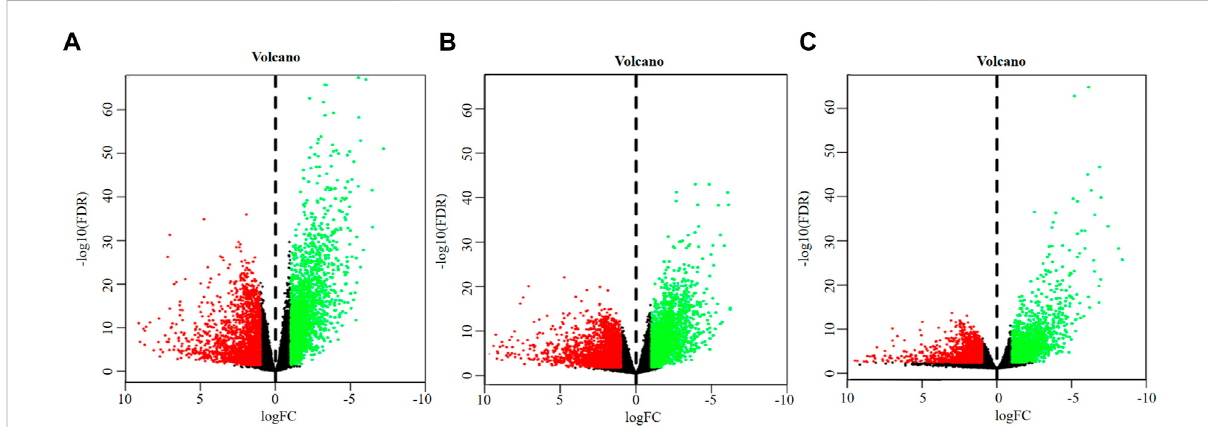
FIGURE 2 VolcanoplotsofDEGs. (A) DEGsofoverall-stageSTADgroup. (B) DEGsoftheearly-stageSTADgroup. (C) DEGsoftheprogressive-stageSTAD group. The abscissa denotes the log 2 transformation value of the differential expression fold change between the STAD samples and the matched paracancerous samples. The ordinate denotes the -log 10 transformation value of the P adj (FDR) value. Green dots symbolize signi fi cantly downregulated mRNAs. Red dots symbolize signi fi cantly upregulated